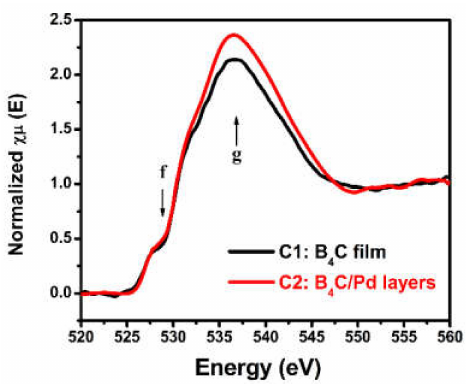
Figure 4. The O K-edge XANES spectra of the B 4 C film and B 4 C/Pd layers placed in the dry oxygen-rich